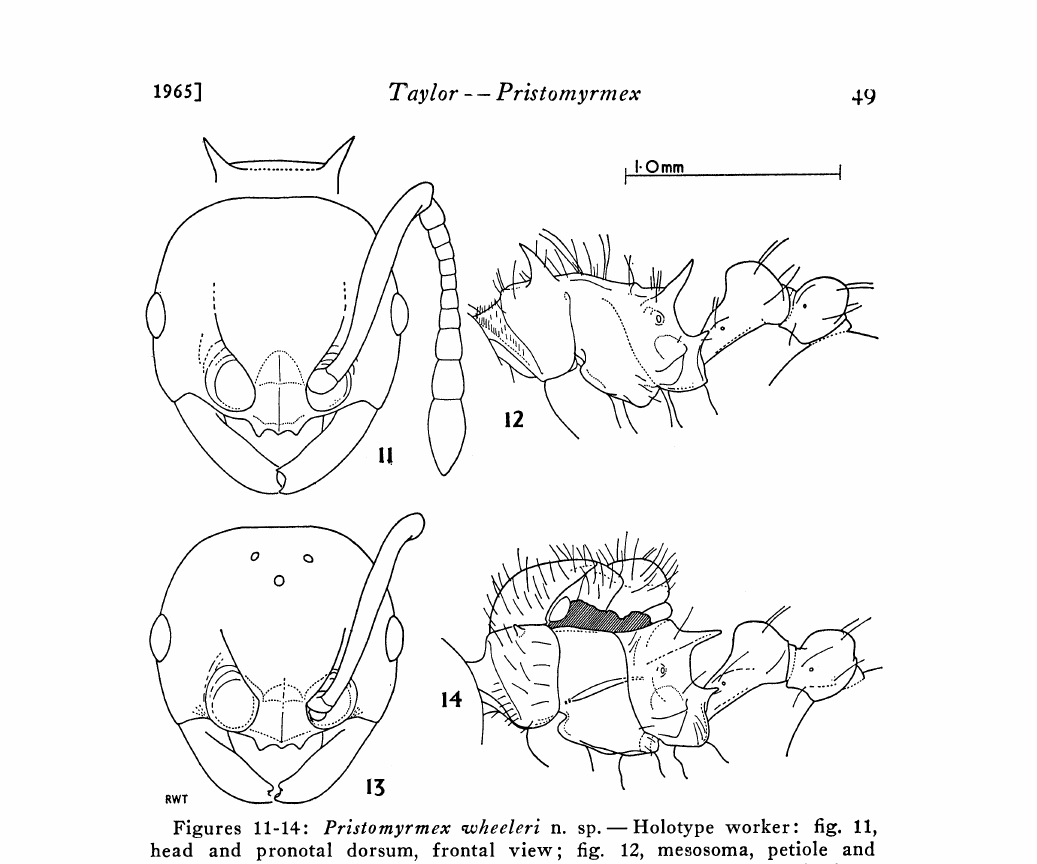
Figures 11-14: Pristomyrmex uheeleri n. sp. mHolotype worker: fig. 11, head and pronotal dorsum, frontal view; fig. 12, mesosoma, petiole and postpetiole, lateral view. mParatype female: fig. 13, head, frontal view; fig. 14, mesosoma etc., lateral view. yellowish. Posterior half of first gastric tergite shaded medium to dark reddish